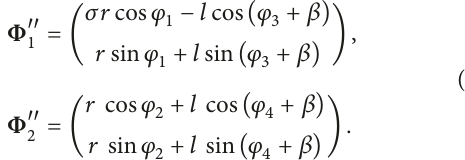
Figure 1: The dual-pendulum-rotor